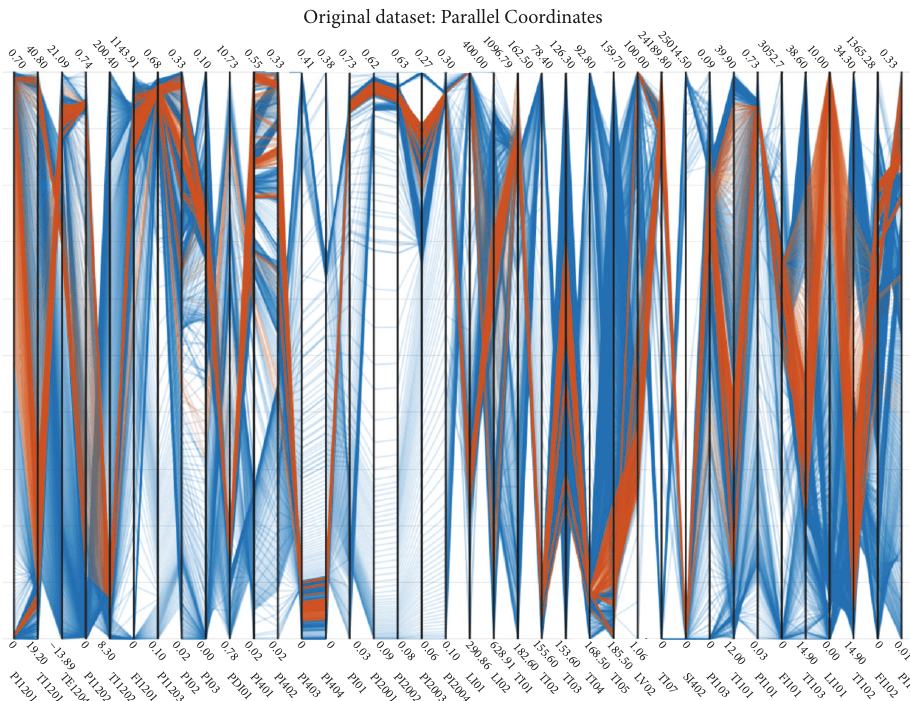
Figure 5: Visual correlation analysis of 38 variables.